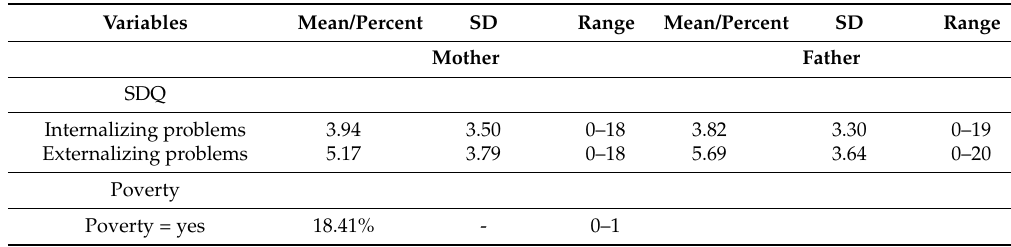
Table 1. Frequency distribution of all variables ( N =